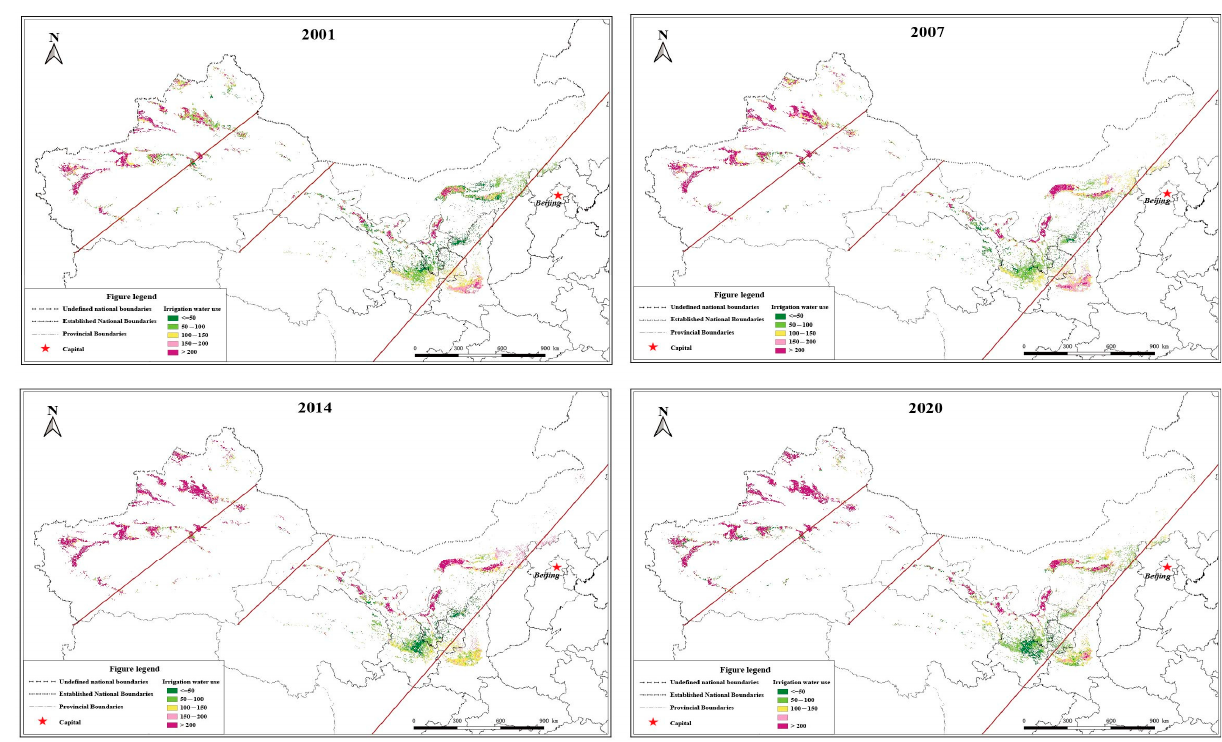
Figure 6. Spatial distribution of EIW in ‘Three Water Lines’ area of northwest China. 3.3.2. Characteristics of the EWI in Sub-Regions of the ‘Three Water Lines’ Area Table 4. EWI of the northwest ‘Three Water Lines’ Statistics on the EWI in the northwest ‘Three Water Lines’ region from 2001 to 2020 are shown in Table 4. The above data and Figure 5 are used to analyze the variation characteristics of the EWI in the northwest ‘Three Water Lines’ area.